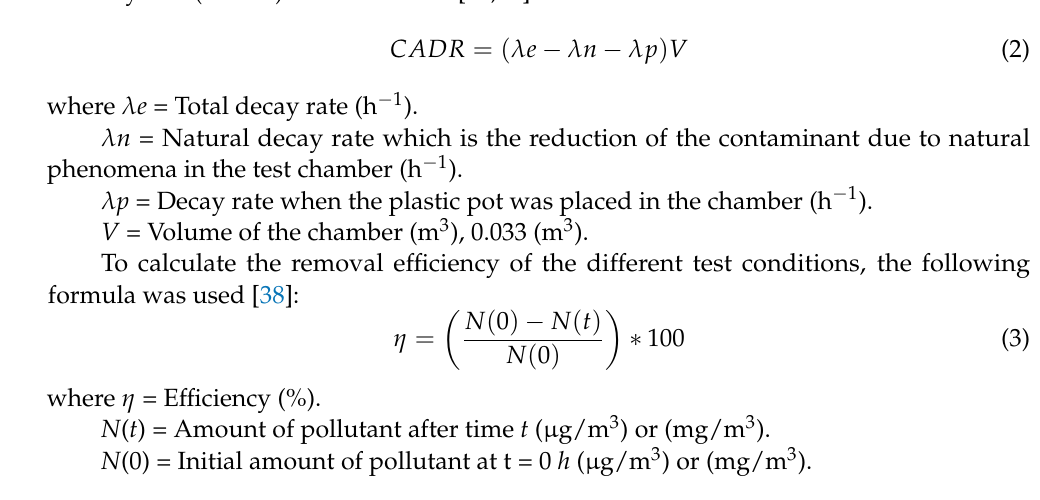
Table 1. CADR of formaldehyde depletion inside of the